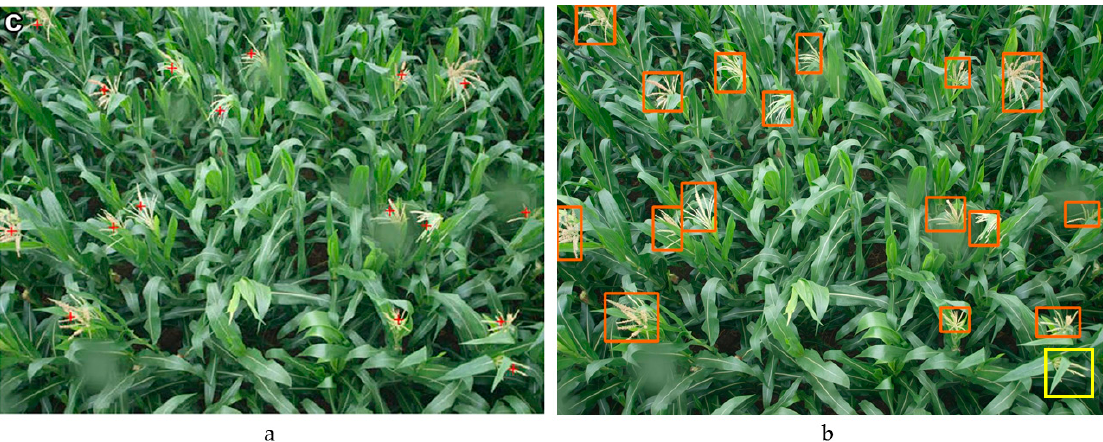
Figure 11. Maize tassels identified by TasselNet ( a ) and by our Faster R-CNN ( b ). The yellow box represents the missed detection of maize tassels by Faster R-CNN.